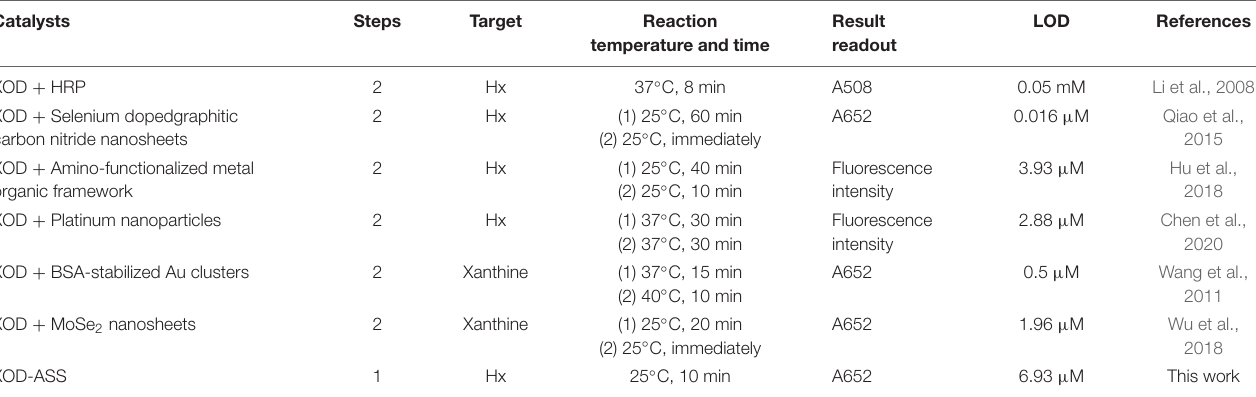
TABLE 2 | Comparison of different Hx detection methods.